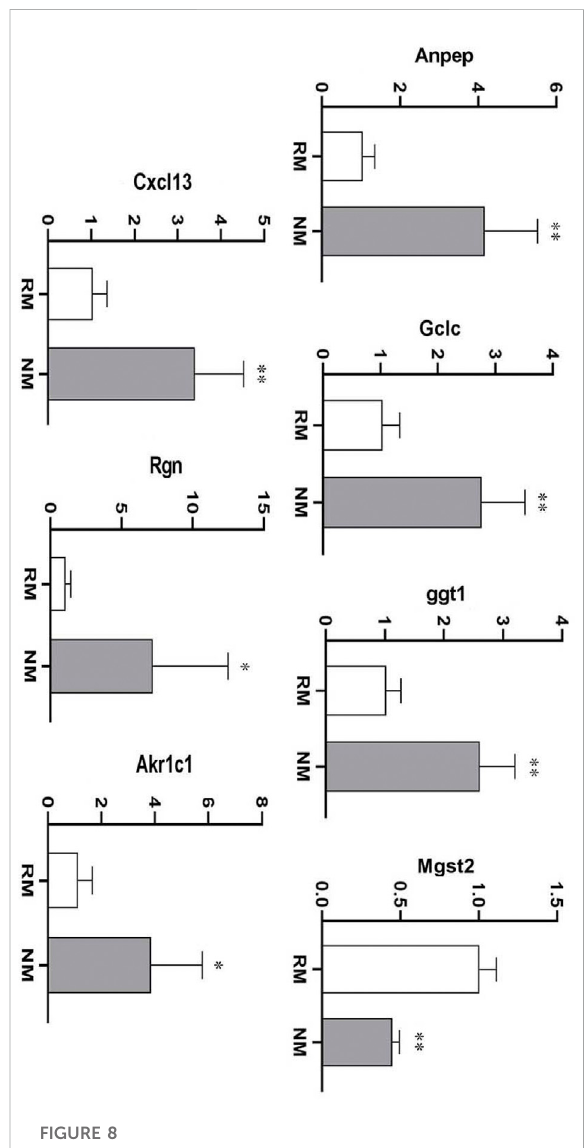
FIGURE 8 mRNA expressionofkeyDEGsin RIAKI ( *p < 0.05, **p <